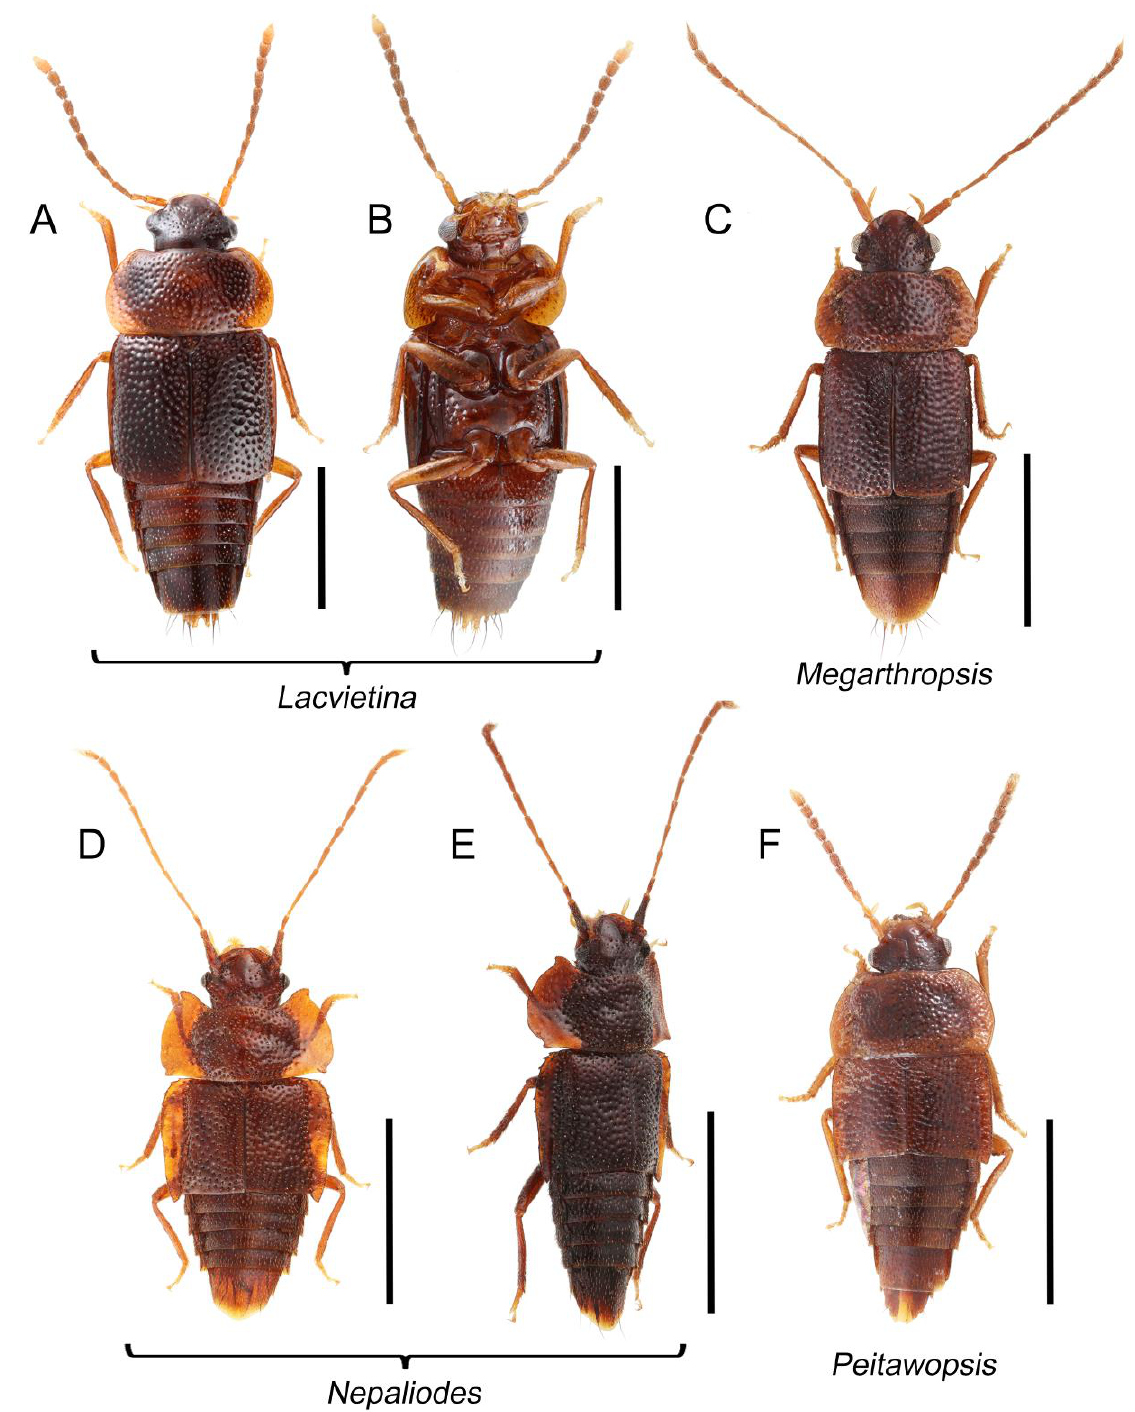
Figure 57. Habitus photographs of Tachinusini: members of the former Megarthropsini. ( A ) Lacvietina takashii (Hayashi), dorsal view. ( B ) Lacvietina takashii , ventral view. ( C ) Megarthropsis decorata , dorsal view. ( D ) Nepaliodes solangelae Herman, dorsal view. ( E ) Nepaliodes solangelae , dorsolateral view. ( F ) Peitawopsis monticola Smetana, dorsal view. Scale bars: 1.0 mm ( A , B ); 1.5 mm ( C , F ); 2.0 mm ( D , E